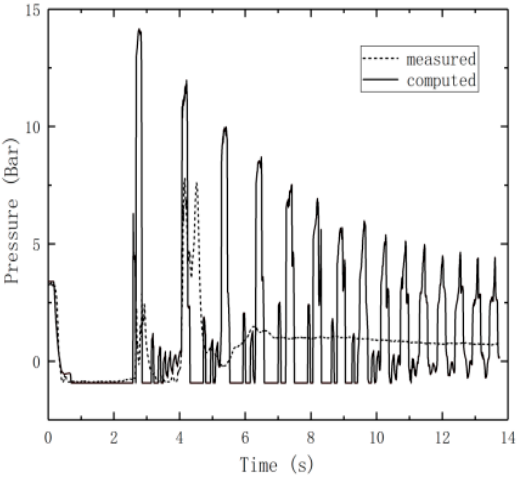
Figure 3. Comparisons of measured and simulated pressures at the Number 1 measurement point before optimization.